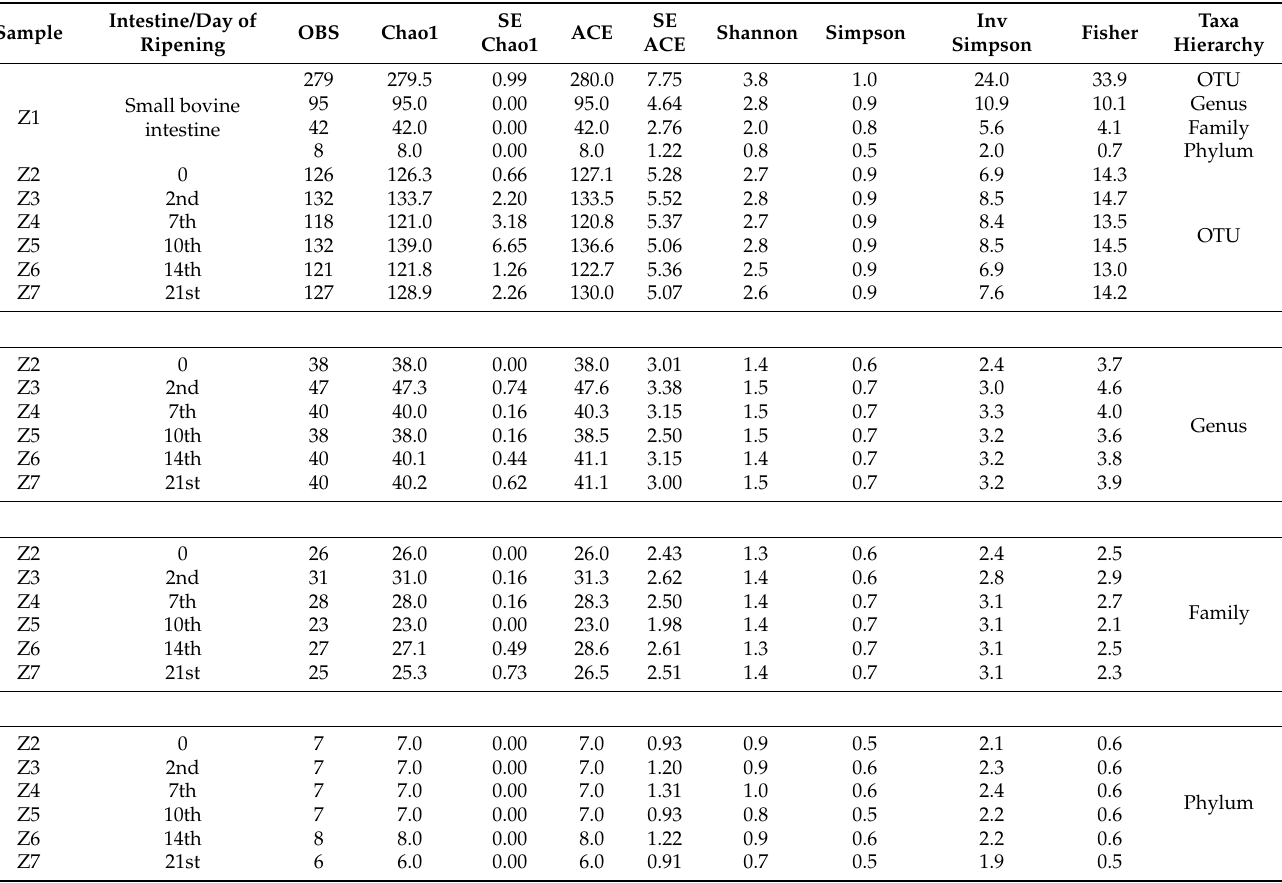
Table 1. Alpha diversity within the analyzed intestine and sausage samples during different time points of ripening, presented at the phylum, family, genus, and OTU